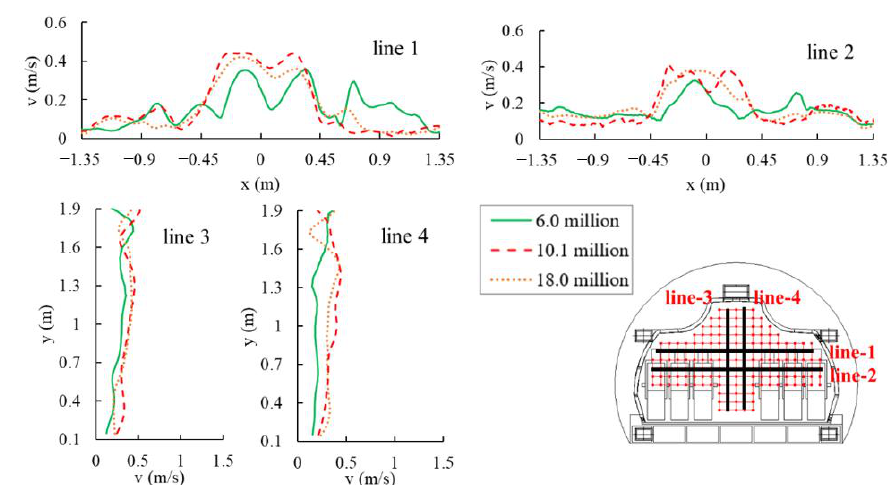
Figure A1. Grid independence test for air velocity in the cross-section.